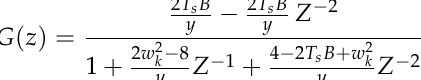
where y = 4 + 2 T s B + w 2 and T s is the sampling frequency of the digitalization process. The bilinear transform approach affects the position of the cutting frequency. Then, it is necessary to correct its value by means of Equation (11).